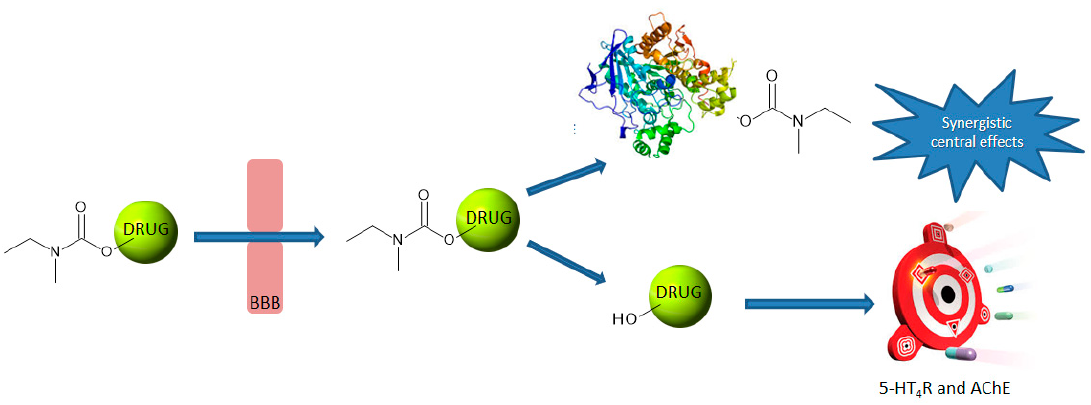
Figure 1. Illustration of the pleiotropic prodrug concept.